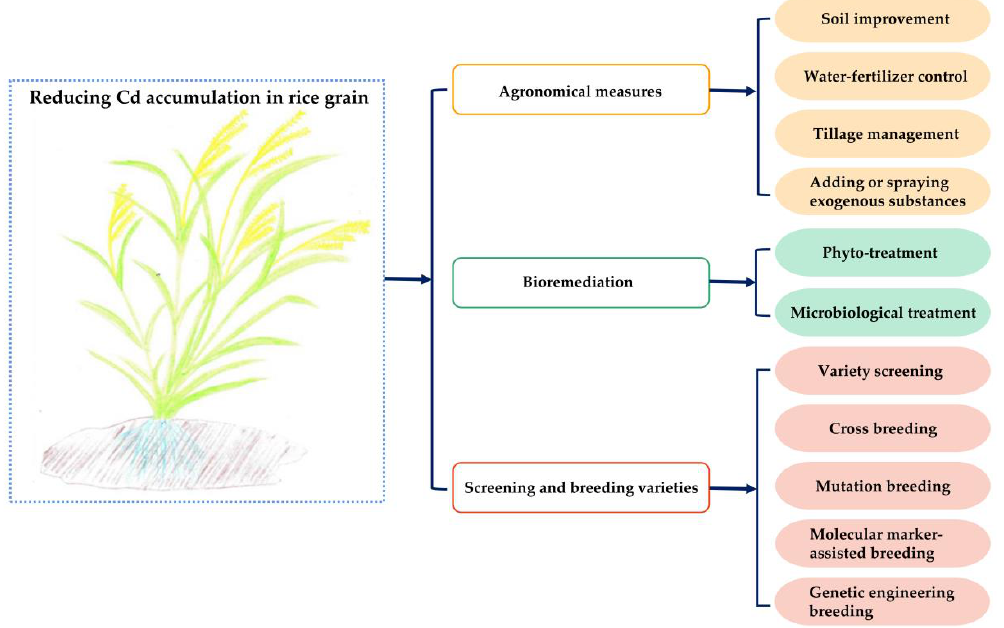
Figure 2. The main strategies for reducing Cd accumulation in rice grains.